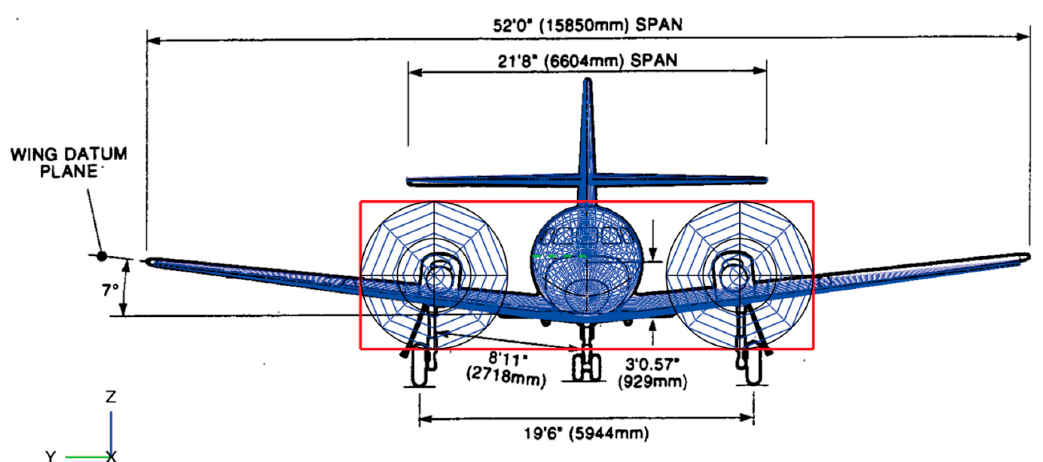
Figure 2. Reference model front view (overlaid on the aircraft maintenance manual [25] view).